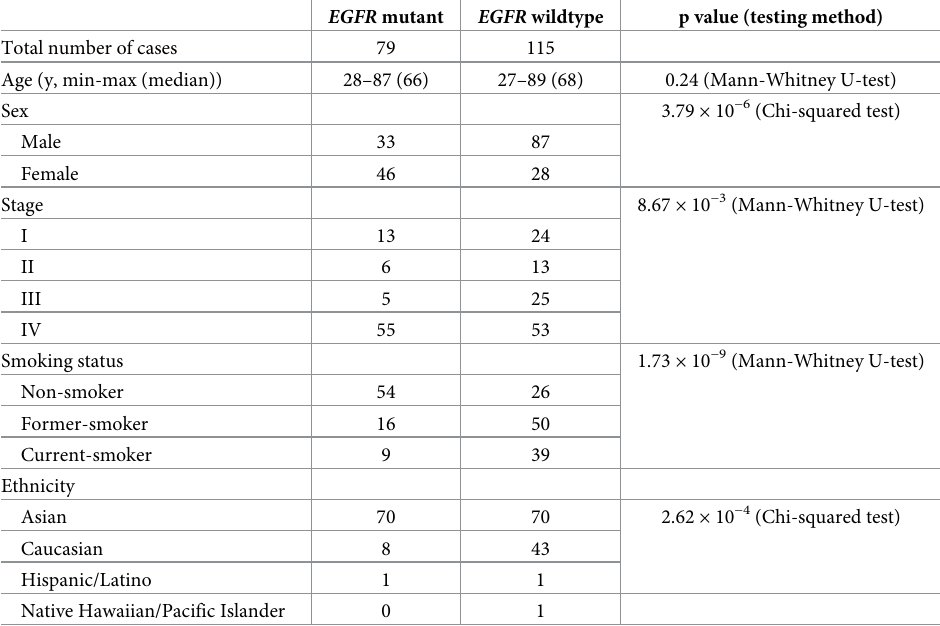
Table 1. Distributions and significant differences in demographic/clinical characteristics between patients with sensitizing epidermal growth factor receptor ( EGFR ) mutants and wildtypes in datasets obtained from University of Malaya Medical Centre, Kyushu University Hospital and The Cancer Imaging